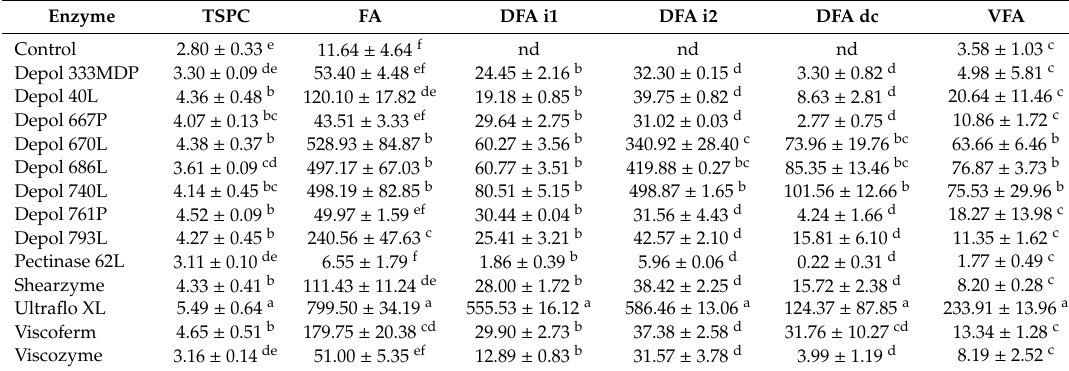
Viscozyme Data are the mean ± standard deviation of two replicates. Di ff erent lowercase letters within a column are significantly di ff erent ( p < 0.05, Duncan’s test). Abbreviations: decarboxylated form of dihydroferulic acid (DFA dc); dihydroferulic acid isomer 1 (DFA i1); dihydroferulic acid isomer 2 (DFA i2); ferulic acid (FA); total soluble phenolic compounds (TSPC); vanillin ferulic acid (VFA). Hydrolysis conditions were enzyme to WB ratio of 1% (w / w), 40 ◦ C, pH 6, and 20